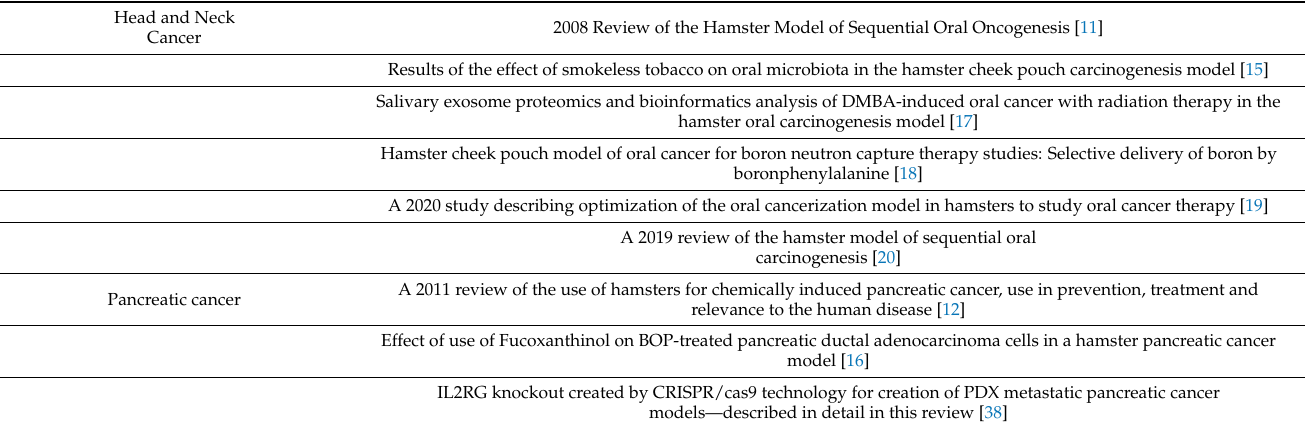
Table 3. Representative literature on hamster cancer models discussed in this